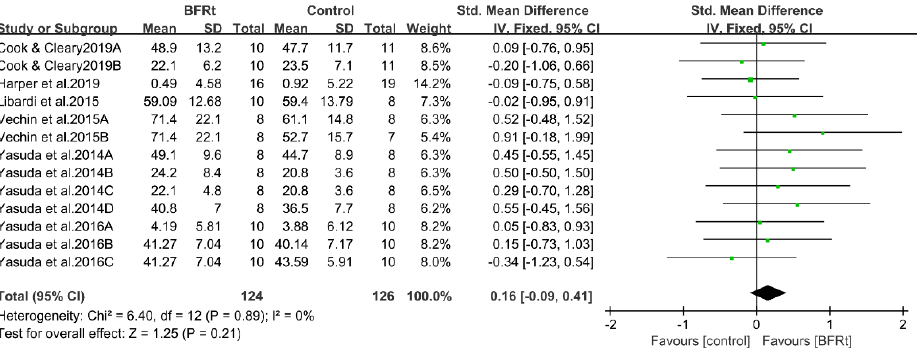
Figure 7. Pooled outcomes of the effects of the BFRt intervention on lower-limb muscle mass. Differ- ent letters for the same study represent different muscle mass assessment methods [19,22,32,33,35,36].